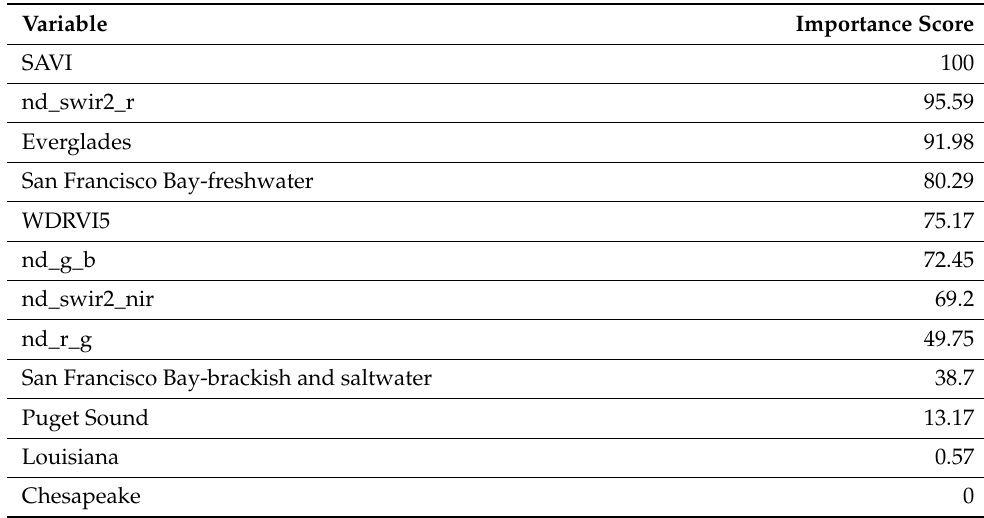
Table 2. Variable importance from the Landsat based random forest biomass